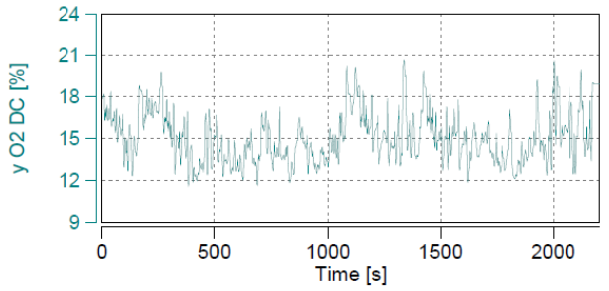
Fig. 6. Oxygen concentration during the test The concentration of oxygen in the exhaust gas reaches its highest values during stops and engine braking.